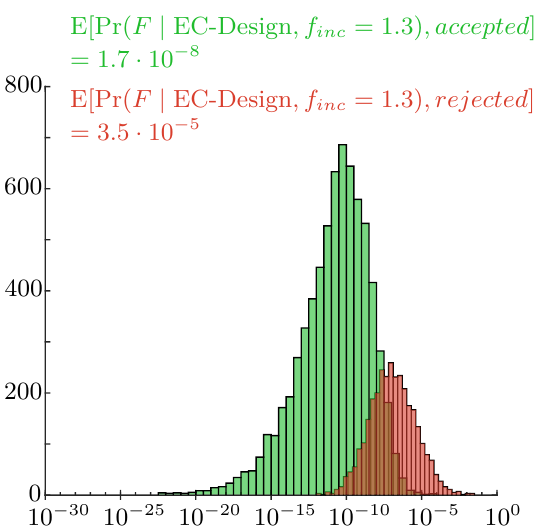
Figure 5. Histogram of the probability of failure Pr( F EC-Design , f inc = 1 . 3) of bridge structures de- | signed following Eurocode loaded by an 30 % increased traffic load divided into accepted (green) and rejected (red) bridges according to advanced traffic load mod-